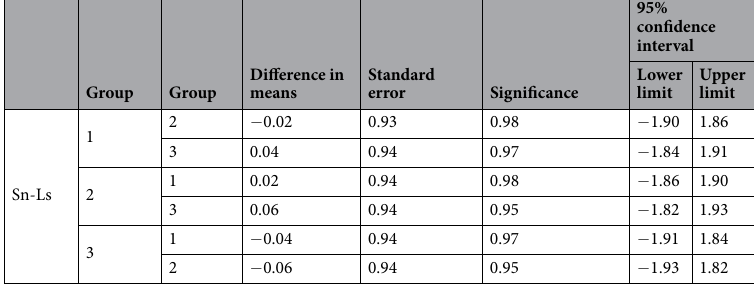
Table 3. Multiple comparisons among the mean values of the three measurements.